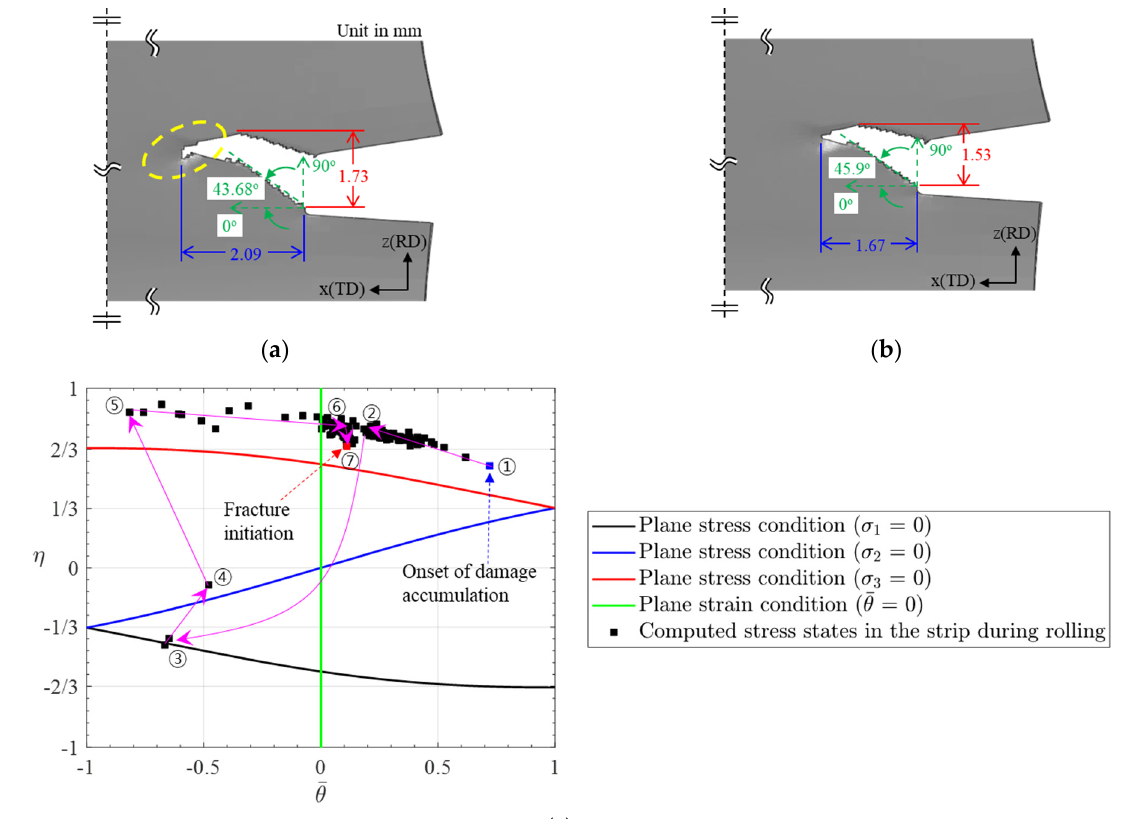
Figure 9. Comparison of edge cracking behavior when ( a ) 2D fracture locus (J–C criterion) was used, and ( b ) 3D fracture locus (MMC criterion) was used; ( c ) Variations in stress states ( η , 𝜃̅ ) at the notch tip of the strip from the beginning of rolling to just before the onset of fracture.